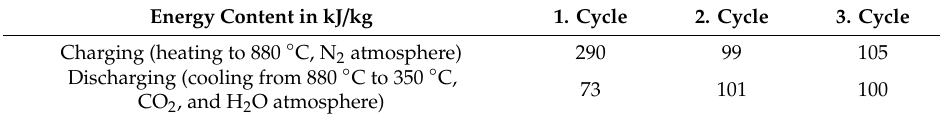
Table 8. Specific energy content of charging and discharging steps of fly ash C-boiler (in kJ / kg). Energy Content in kJ / kg 1. Cycle